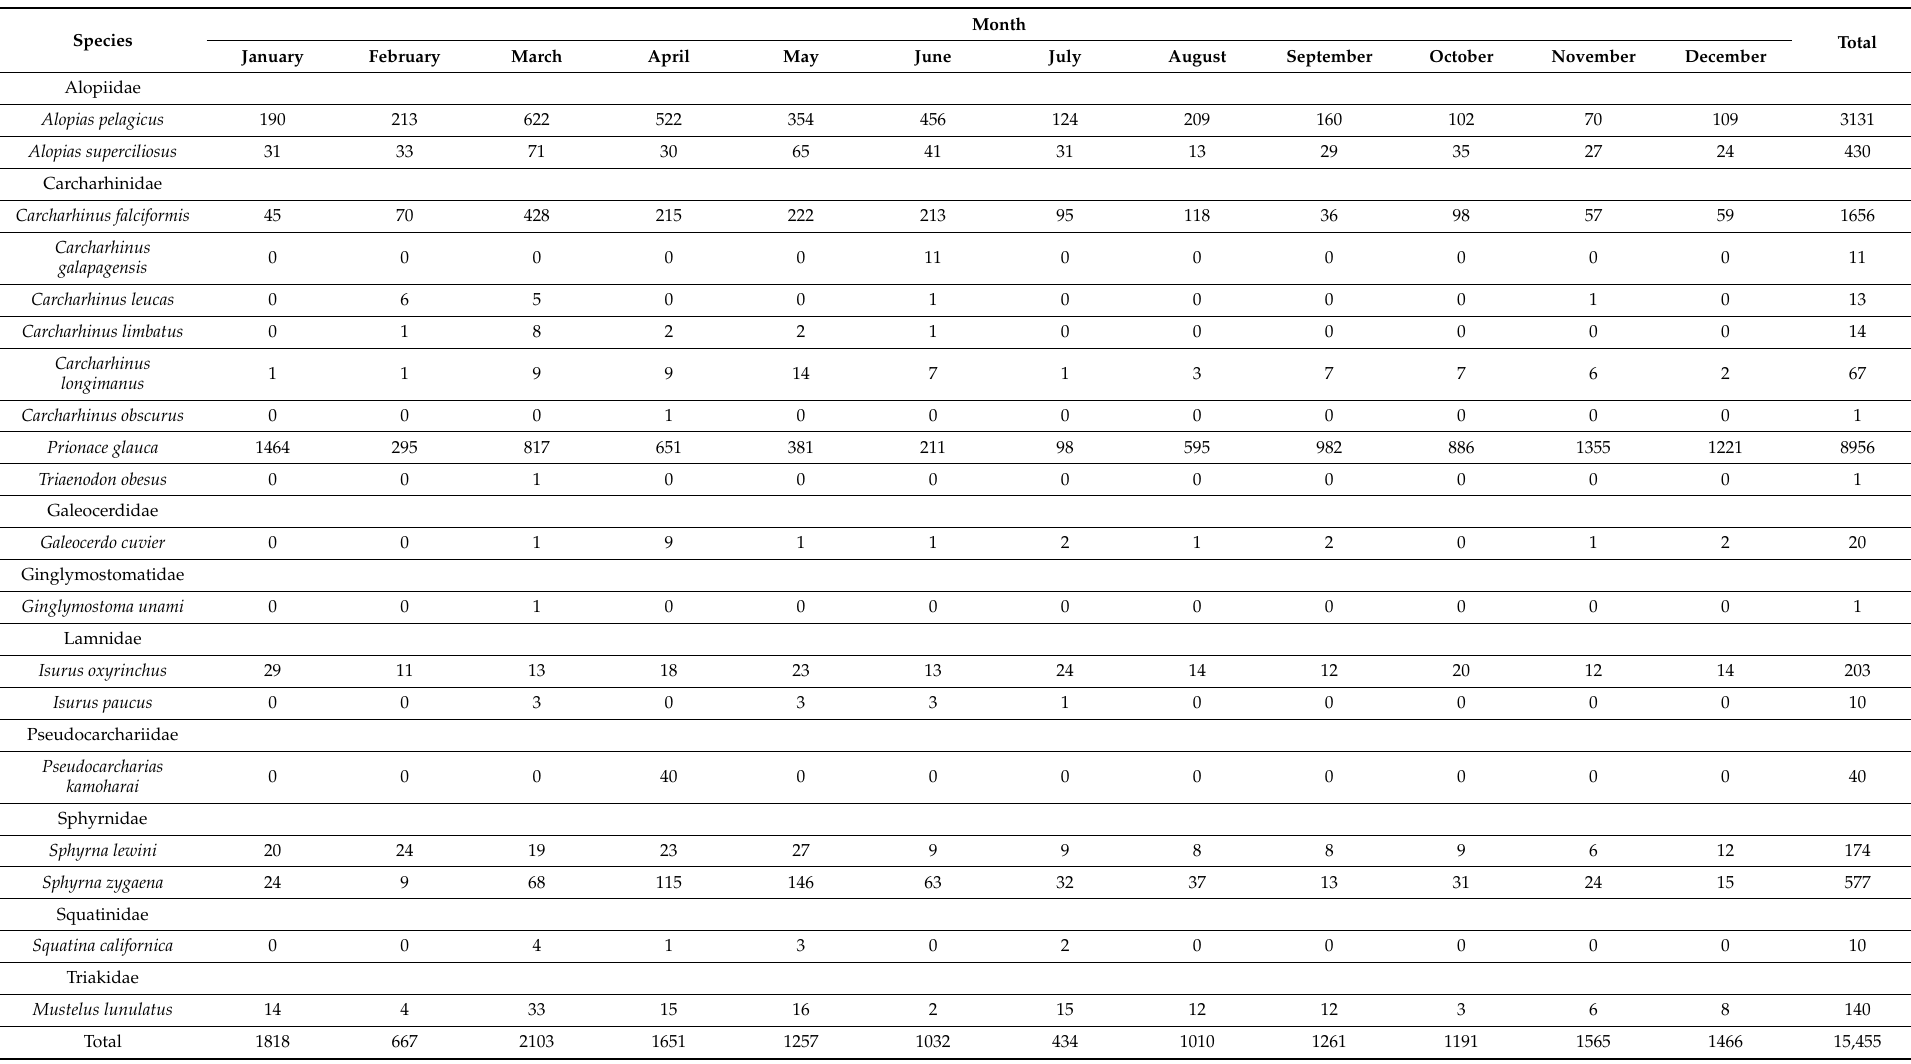
Table 2. Sharks registered monthly in number during the year 2019 in